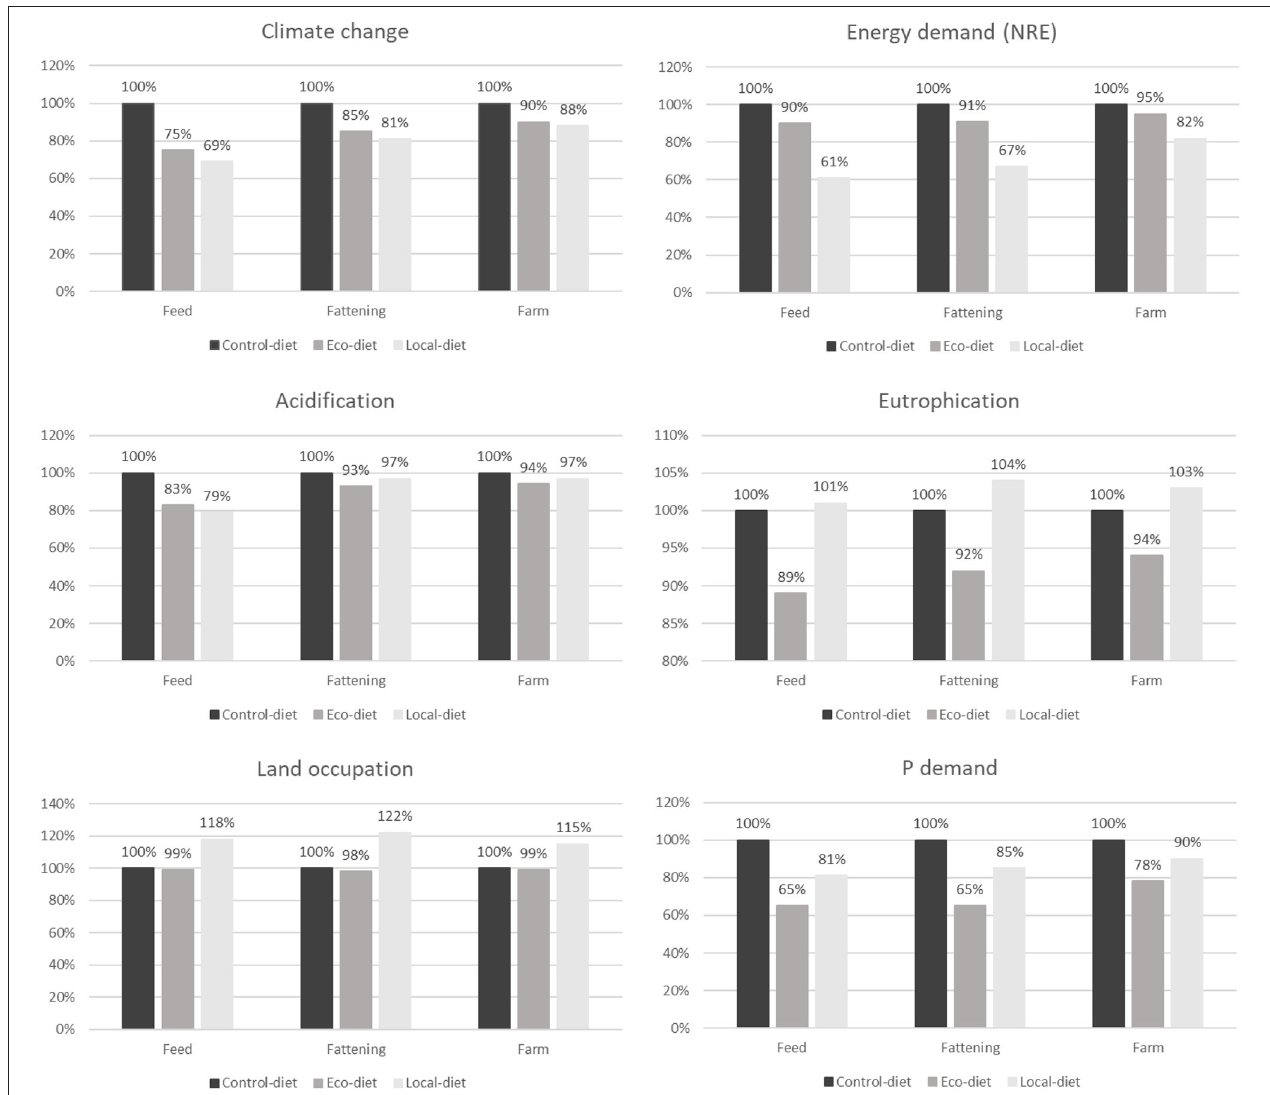
FIGURE 2 | Effect of the strategy for diet formulation on environmental impacts of the average feed and of pig production at fattening unit gate or at farm gate. Values are expressed as a percentage of the value obtained for the Control-diet